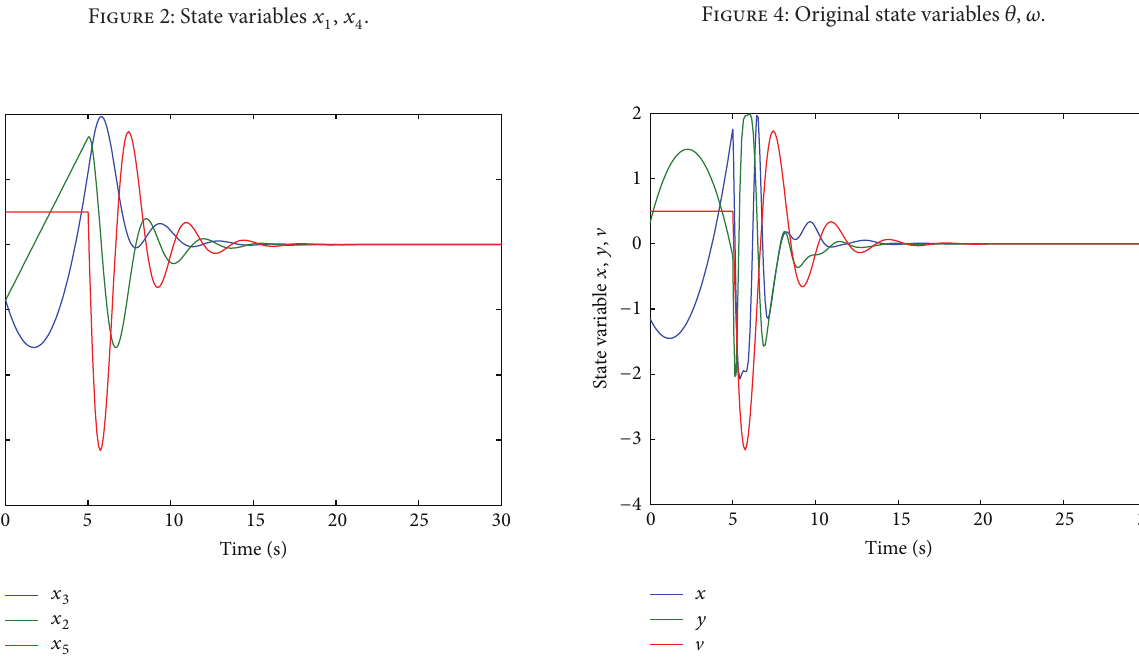
Figure 3: State variables 𝑥 3 , 𝑥 2 , and 𝑥 5 .